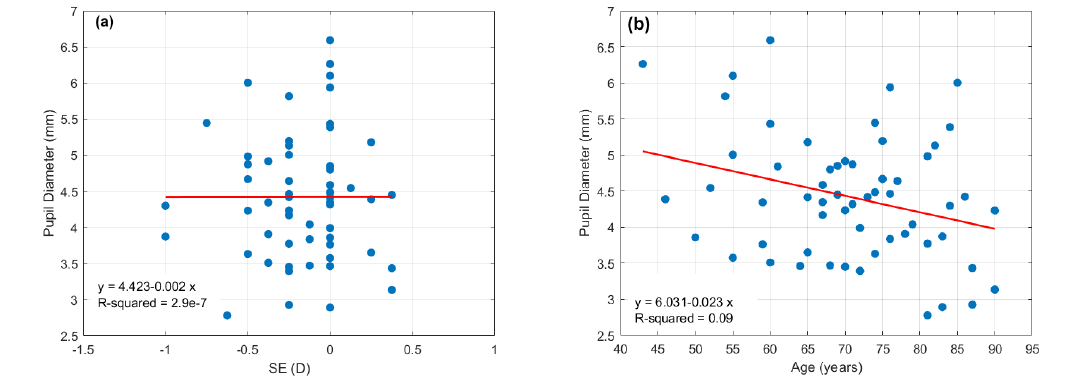
Figure 2. ( a ) Far distance (3.0 m) pupil diameter versus subjective spherical equivalent. ( b ) Far distance (3.0 m) pupil diameter versus age.